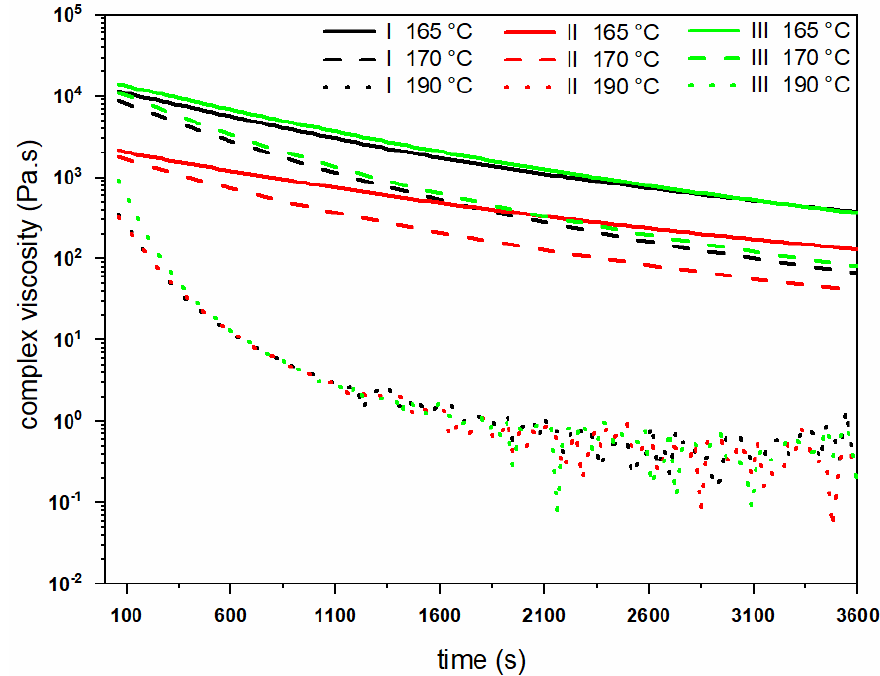
Figure 4. Change in complex viscosity of PHBH polymer grades at 165, 170 and 190 °C. Figure 5 shows the loss (G”) and storage modulus (G (cid:48) ) of different PHBH grades versus time at different testing temperatures. All polymer grades show rapid degradation pathways in their molten states at all temperatures. The decay in melt rheological properties becomes stronger as the temperature is increased to the maximum temperature (190 ◦ C). Similar to the complex viscosity results, polymer grade III has the highest initial